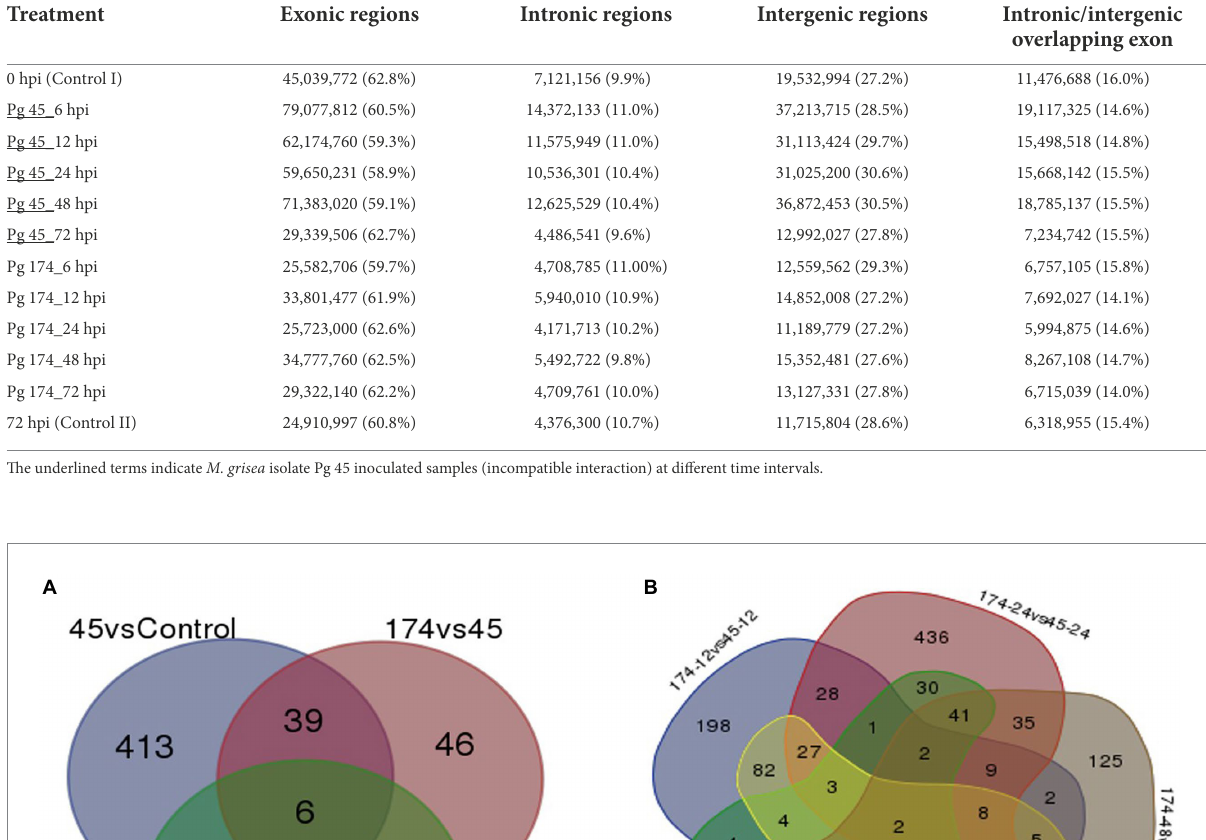
TABLE 2 Mapping statistics of RNA-Seq reads aligned to different parts of the pearl millet genome during incompatible and compatible interactions to blast pathogen. Treatment